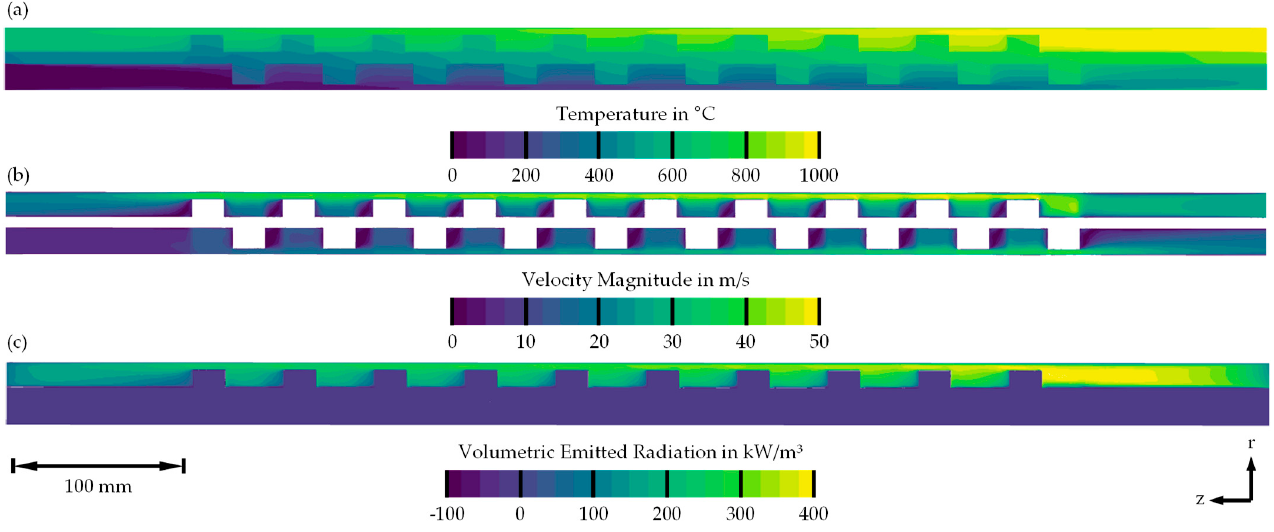
Figure 9. Temperature ( a ), velocity magnitude ( b ), and volumetric emitted radiation ( c ) shown on the axial cross-section of the geometry for P = 160 kW, λ = 1.15, and T o = 1000 ◦ C.